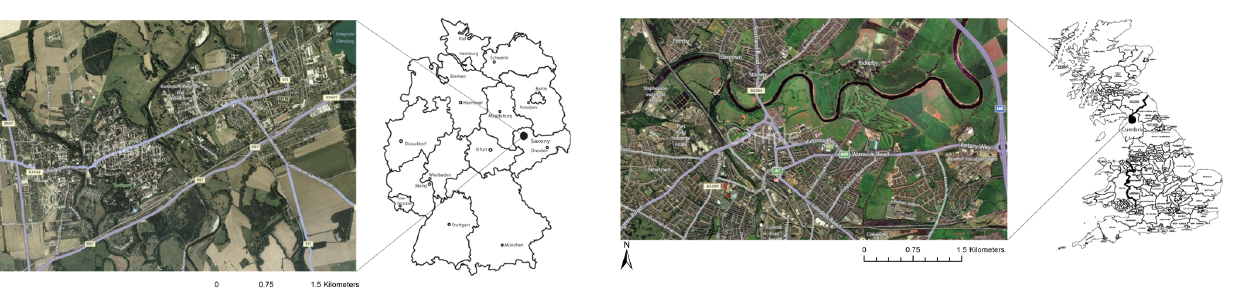
Fig. 2. Location and map of the case study area of Carlisle in the county of Cumbria, United